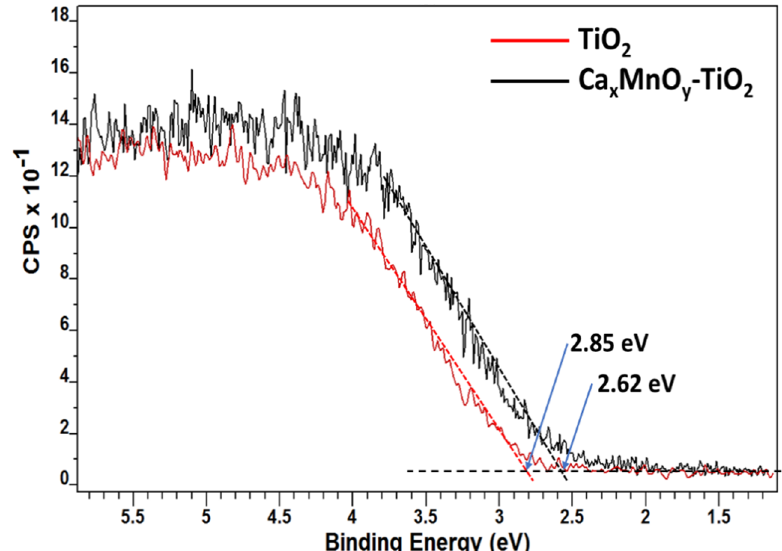
Figure 5. Valence Band XPS of TiO 2 and Ca x MnO y -TiO 2 .